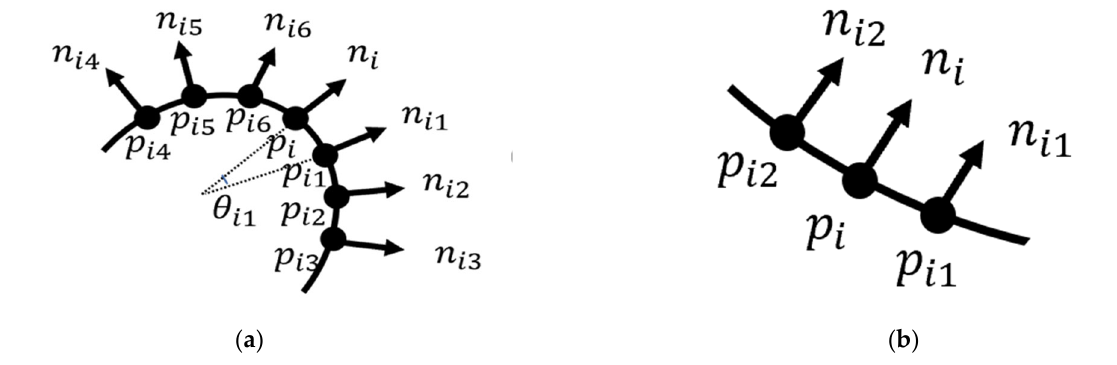
Figure 6. Smoothness of the region: ( a ) undulating region; ( b ) smooth region.